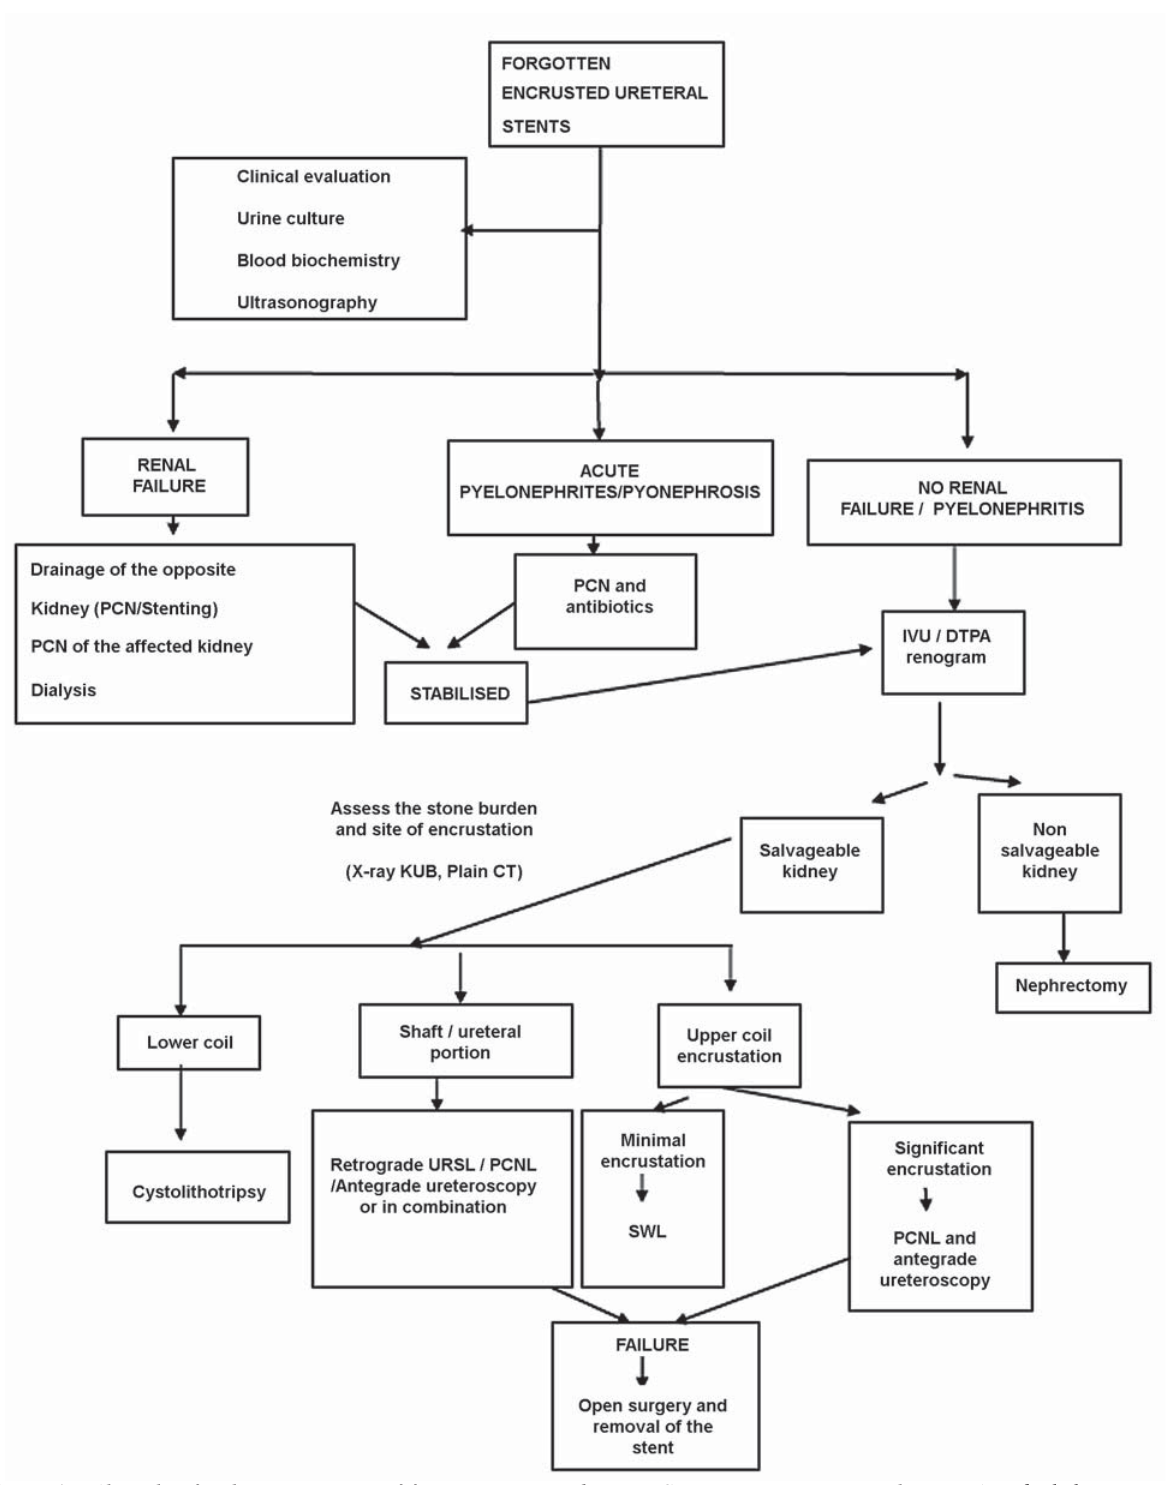
Figure 4 – Algorithm for the management of forgotten encrusted stents. CT = computer tomography; DTPA = diethylenetriamine penta-acetic acid; SWL = extracorporeal shock wave lithotripsy; IVU = Intravenous Urogram; KUB = kidneys, ureters, and bladder; PCNL = percutaneous nephrolithotomy; URSL = ureterorenoscopic